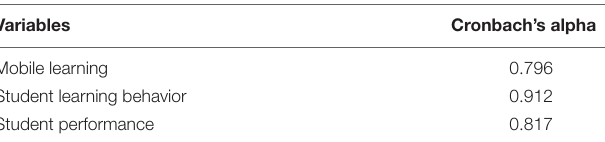
TABLE 2 | Reliability statistics.